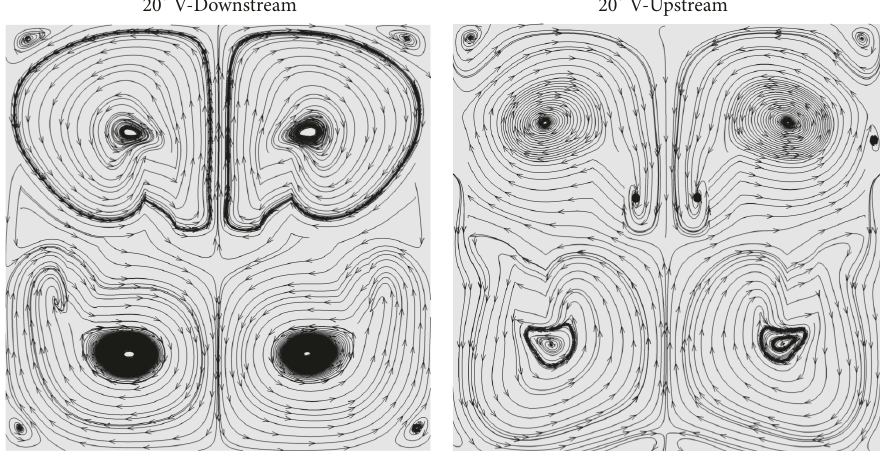
Figure 5: Streamline in transverse planes for the square channel heat exchanger inserted with 20 ∘ V-wavy plate at Re = 3000.